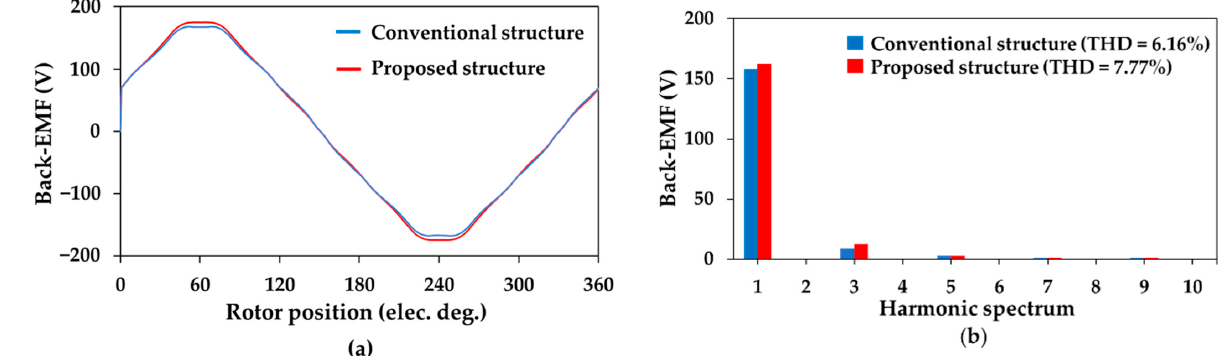
Figure 6. ( a ) Open-circuit phase back-EMF waveforms and ( b ) its spectrum.